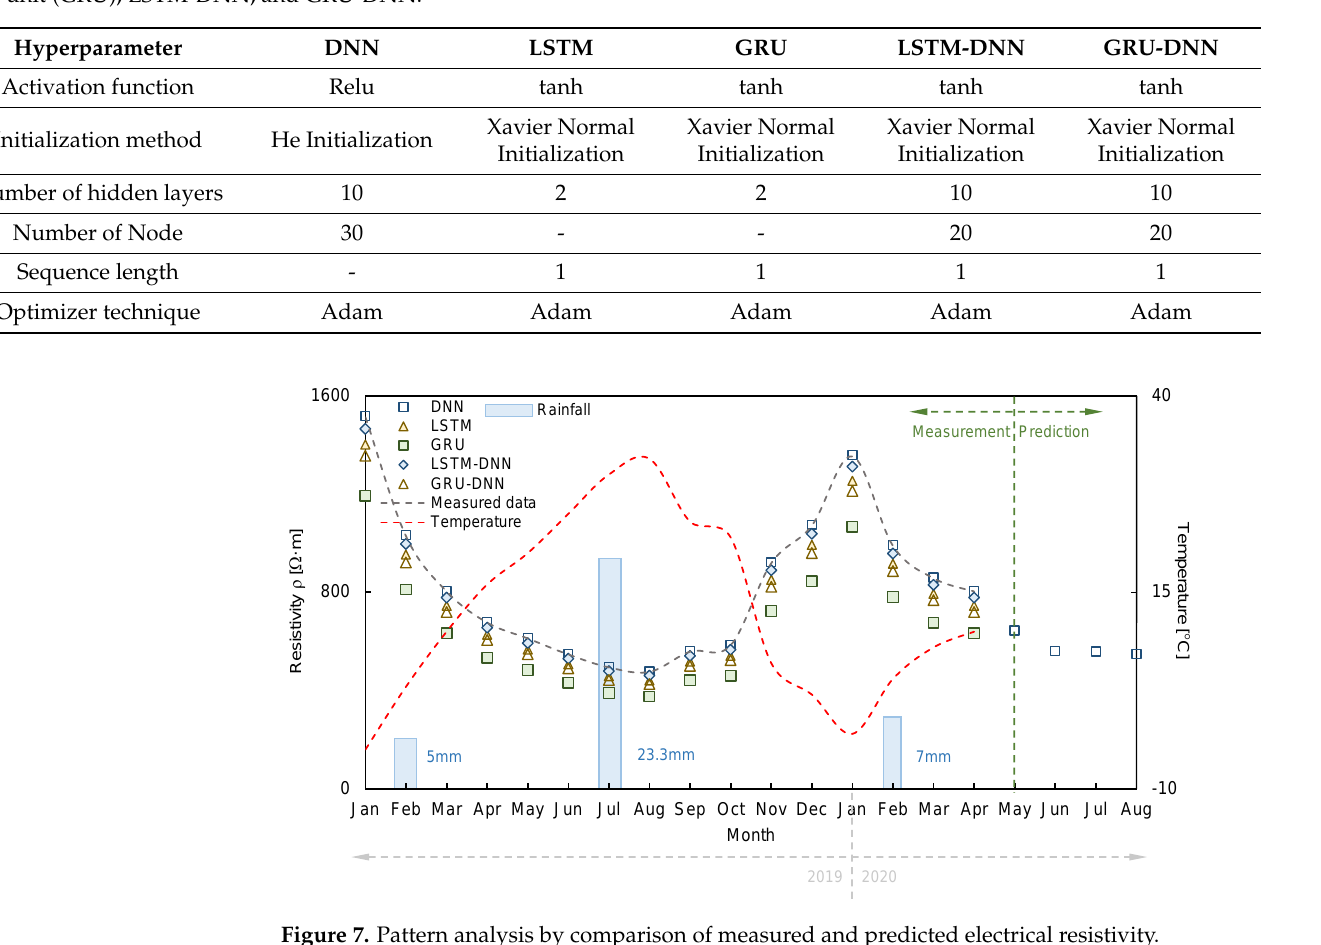
Figure 8. Box plots of DNN, LSTM, GRU, LSTM-DNN, and GRU-DNN between the measured and predicted electrical resistivity. 6. Discussion 6.1. Prediction of Porosity According to the results of the sieve analysis, the fine content was less than 4.2%, and the area was almost entirely composed of sand particles based on the unified soil classifi- cation system (USCS). Therefore, the intrinsic formation factor of Equation (2) can be ap- plied as the apparent formation factor, and the measured value was used for the bulk electrical resistivity. The alternation of fluid electrical resistivity was assumed to be small at each position because the change of ions in a porous medium is tiny due to the small content of the fine particles. Moreover, a constant fluid electrical resistivity of 116.27  ·m, measured in the stored rainfall through the 4-electrode technique, was used. More infor- mation on the 4-electrode technique can be found in Taiwo et al. [30]. The estimated po- rosity based on a dynamic cone penetrometer test (DCPT) was estimated to obtain the tortuosity factor and the cementation factor through inversion. The results of DCPT at a horizontal distance of 80 m, 120 m, and 160 m are shown in Figure 9.